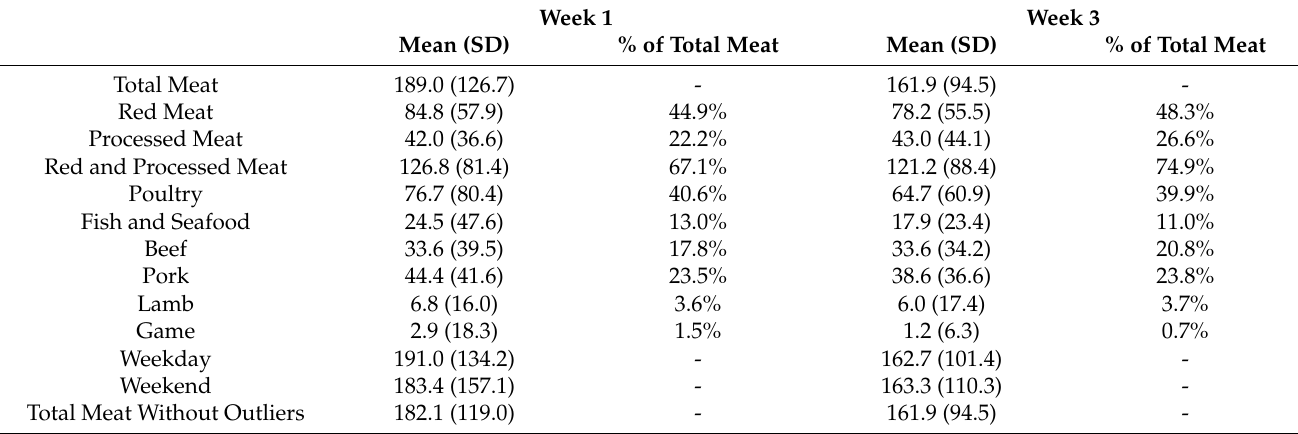
Table 2. Mean daily intake of meat categories in Week 1 and Week 3 as assessed by the